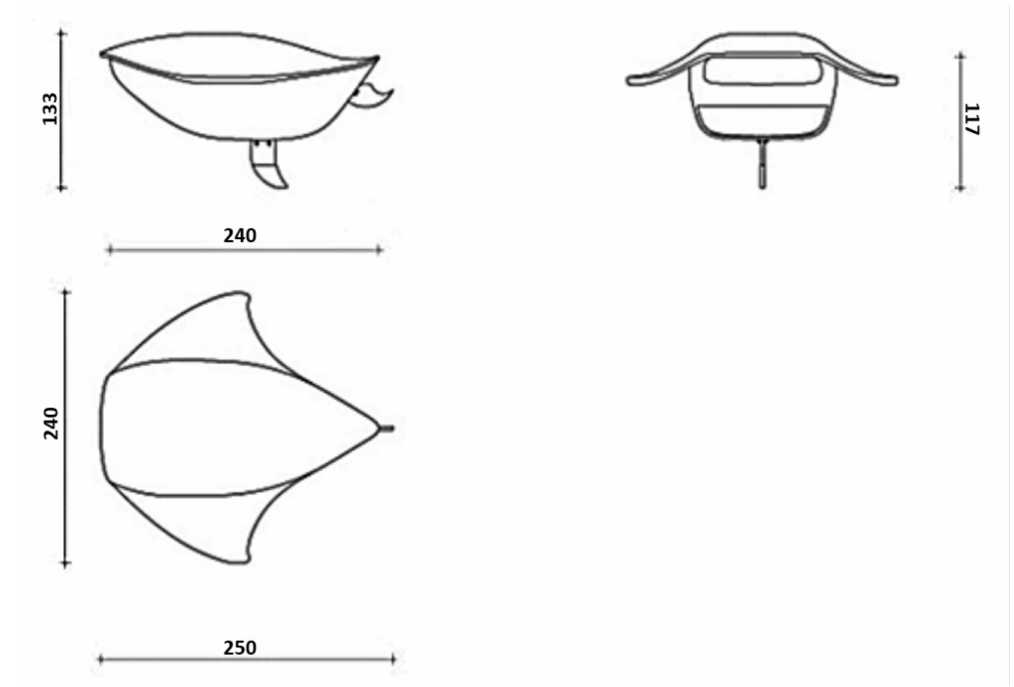
Figure 14. Design engineering: orthogonal projections, measures in